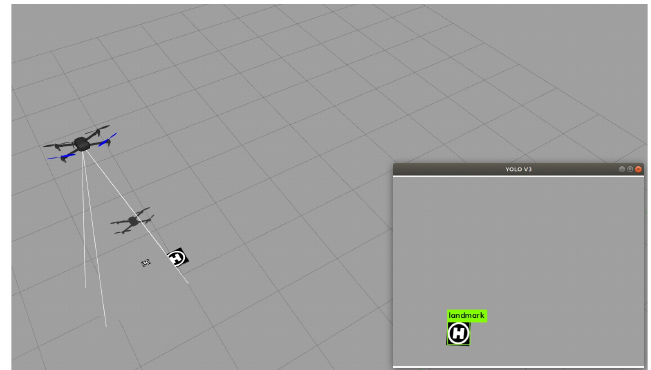
Figure 8. Flight test in the simulation environment.